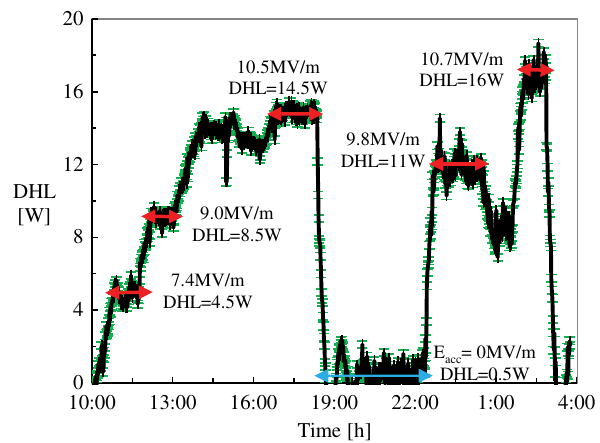
¼ 7 . 0 and 9 . 5 MV = m; 2 K (left), 1.8 K acc ¼ 0 MV = m was DHL ¼ 0 ½ W (cid:3) acc